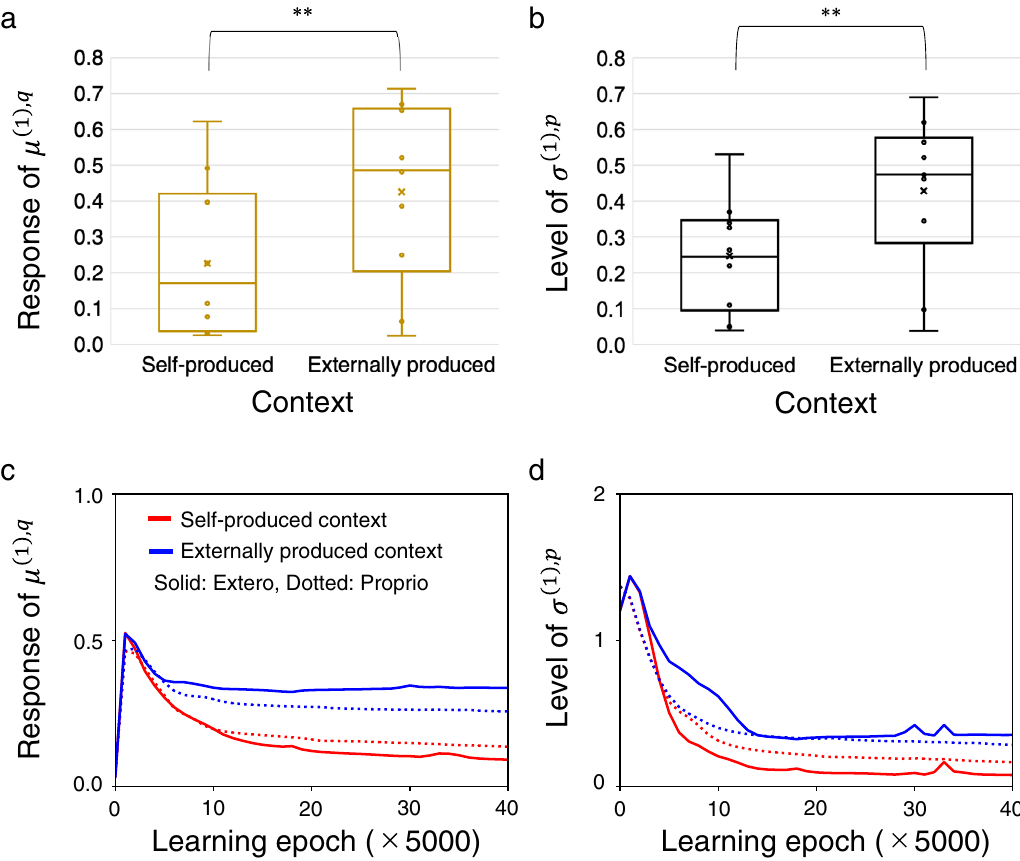
Figure 4. Sensory-level neural response in the test phase and its development in the learning phase. ( a ) Box-and-whiskers plots showing the difference in sensory-level posterior response between self-produced and externally produced contexts. ( b ) Box-and-whiskers plots showing the difference in the sensory-level prior sigma between the two contexts. In ( a , b ), each plot is an average of 100 time steps, 2 sensory areas, and 8 test trials by each of 10 trained networks (center line, median; cross, mean; box limits, upper and lower quartiles; whiskers, × 1.5 interquartile range). ** p < 0.01 . ( c ) Development of the posterior response for the two contexts in the exteroceptive and proprioceptive areas. ( d ) Development of sensory-level prior sigma. In ( c , d ), the value is averaged over 200 time steps, 24 training datasets, and 10 different networks in each learning